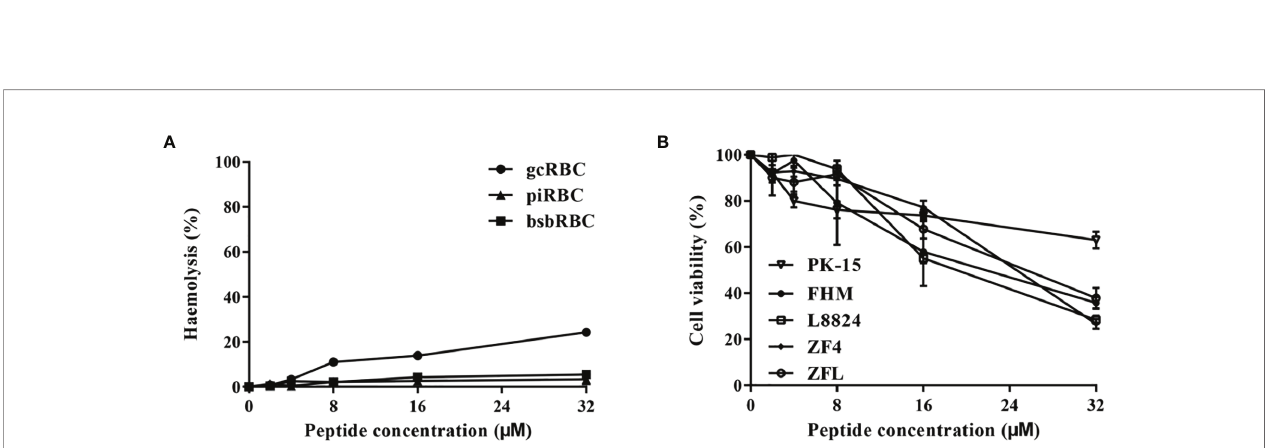
FIGURE 5 | The hemolytic and cytotoxic activities of Tatritin against erythrocytes and cell lines from fi sh and pig. (A) The Tatritin peptide was added to the erythrocytes of grass carp (gcRBC), blunt snout bream (bsbRBC), and domestic pig (piRBC) and incubated at 24 ˚ C for 2 h, and then OD 405 of the supernatant was measured. (B) The Tatritin peptide was added to the cells of PK15 ( Sus scrofa ), FHM ( Pimephales promelas ), L8824 ( Ctenopharyngodon idella ), ZFL ( Danio rerio ), and ZF4 ( D. rerio ) and incubated at 28 ˚ C for 48 h; CCK-8 solution was then added and incubated at 28 ˚ C for an additional 4 h. The absorbance was subsequently measured at 450 nm. Data shown are the means ± SD (n =